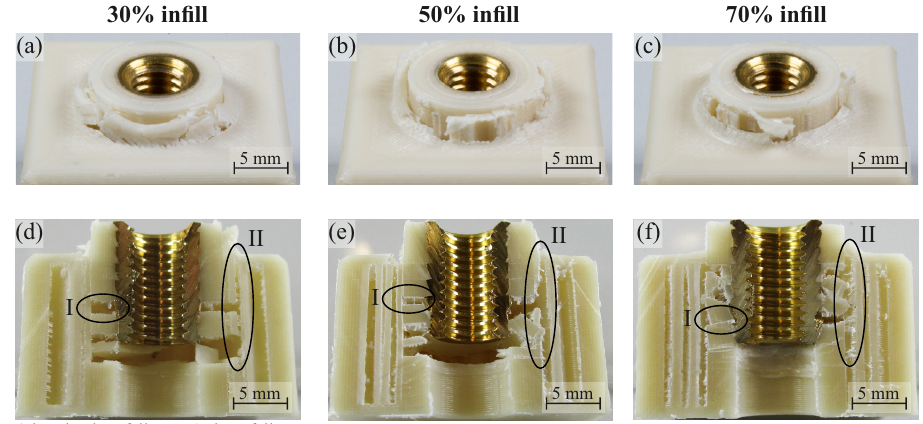
Figure 8. Exemplary test specimens of the test series with varying infill density: top view ( a – c ) and sectional view ( d – f